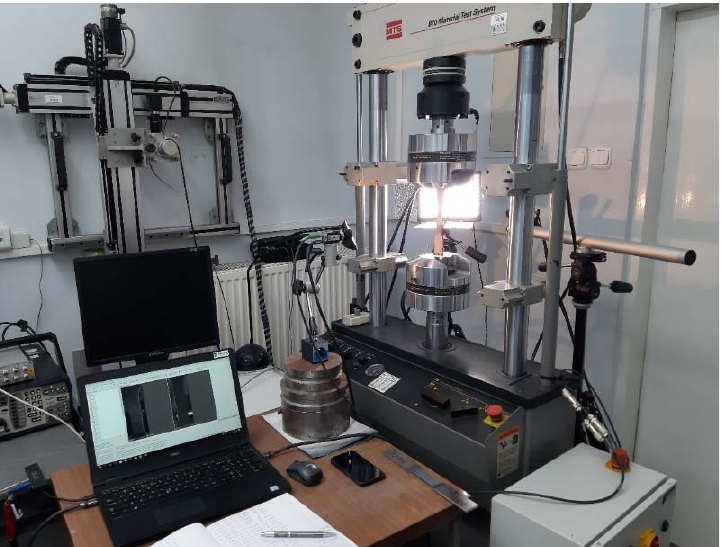
Figure 3. Stand for static tensile tests with simultaneous analysis of sample deformation based on the digital image correlation system (DIC), simultaneously recording the image of both flat surfaces of the tested sample.